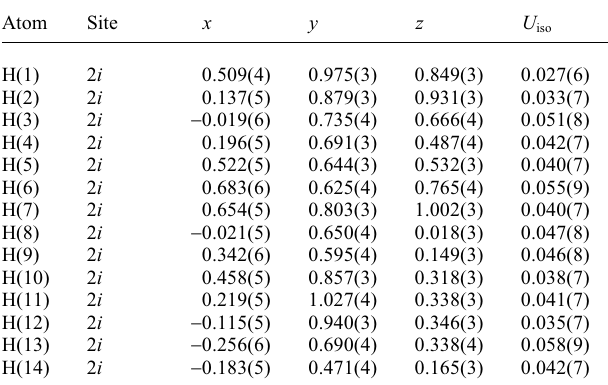
Table 2. Atomic coordinates and displacement parameters (in Å 2 )